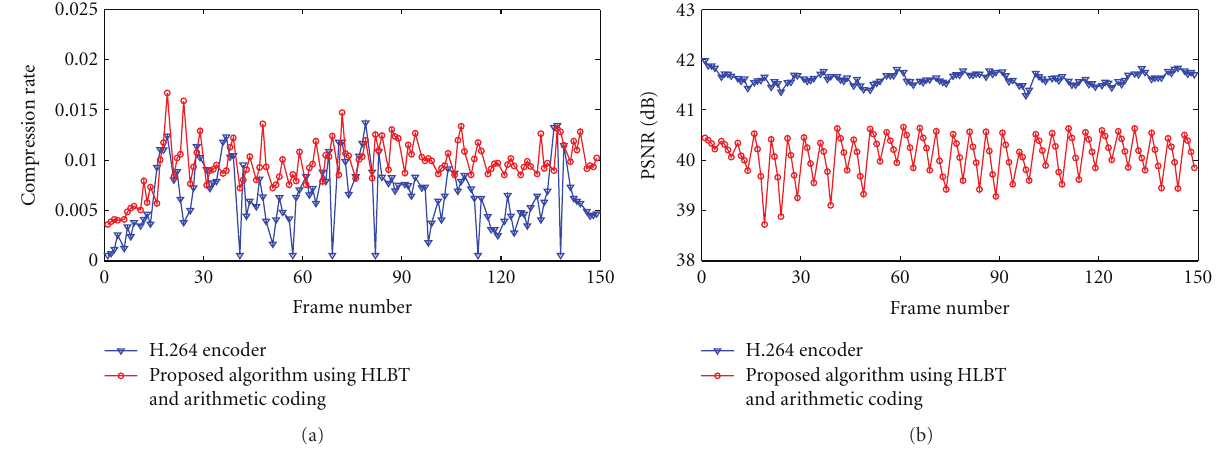
Figure 20: Simulation results with the Akiyo video: (a) the compression rate and (b) the quality of video.